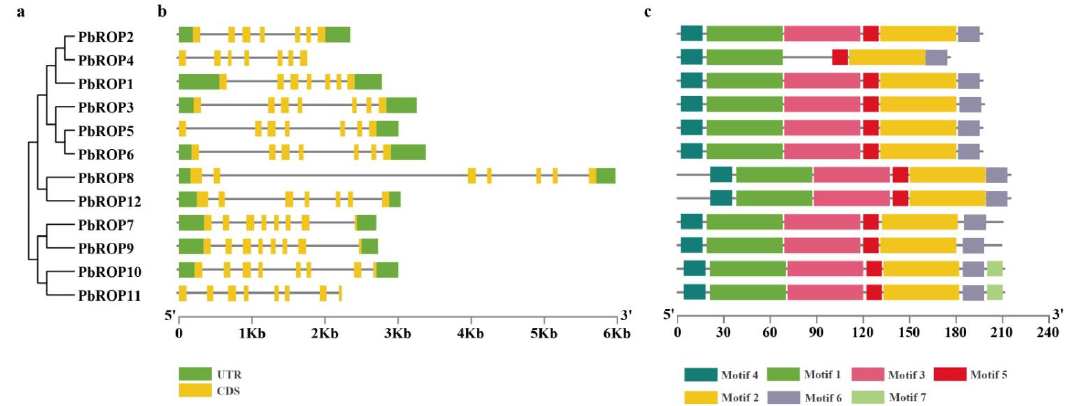
Figure 4. Phylogenetic relationships, gene structure, and conserved motifs of the encoded proteins of PbROPs of ‘ Duli ’ pear ( Pyrus betulifolia Bunge). ( a ) The phylogenetic tree. It was constructed based on the full-length PbROP protein sequences using MEGA 5.0 software. ( b ) Gene structure of